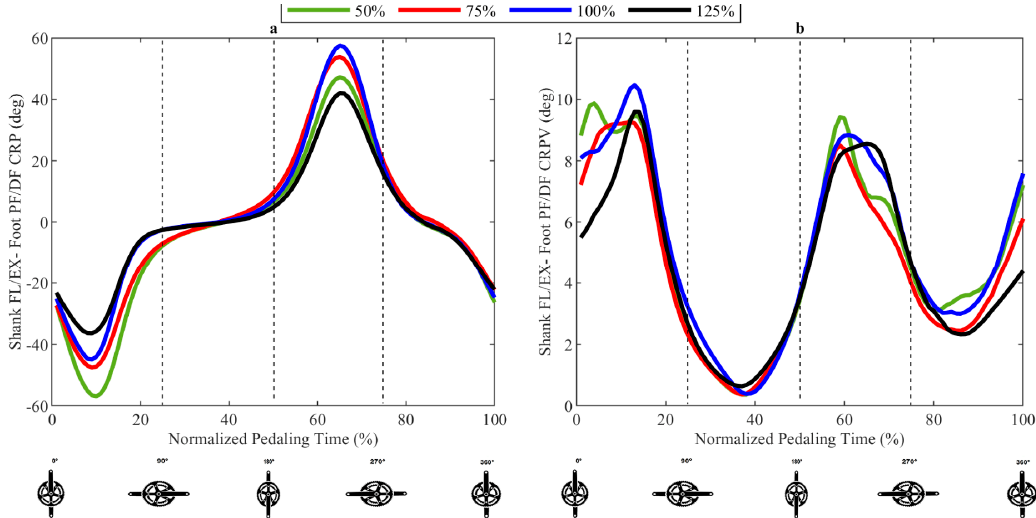
Figure 5. Shank flexion/extension (FL/EX)-Foot plantarflexion/dorsiflexion (PF/DF) continuous relative phase (CRP) ( a ) and continuous relative phase variability (CRPV) ( b ) in different pedaling intensities .